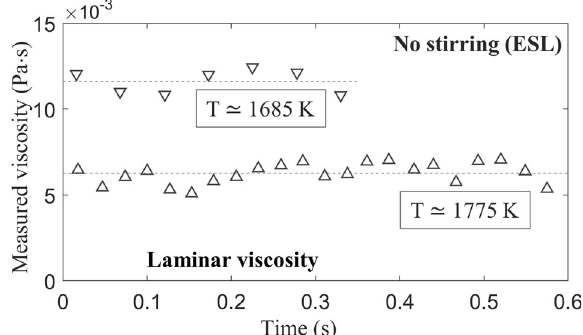
Fig. 2 Measured viscosities using the ESL. The example shows the measured viscosities of a molten FeCrNi droplet as a function of elapsed time at constant temperatures.